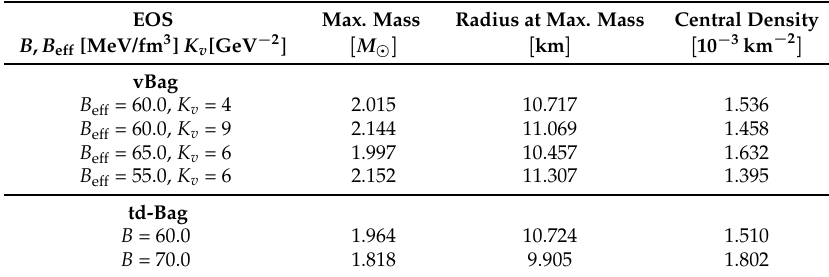
Table 2. Maximum mass and corresponding radius for critically stable stellar configurations in the vBag model of strange stars. All configurations with higher central densities are unstable against oscillations, i.e., have ω 2 <